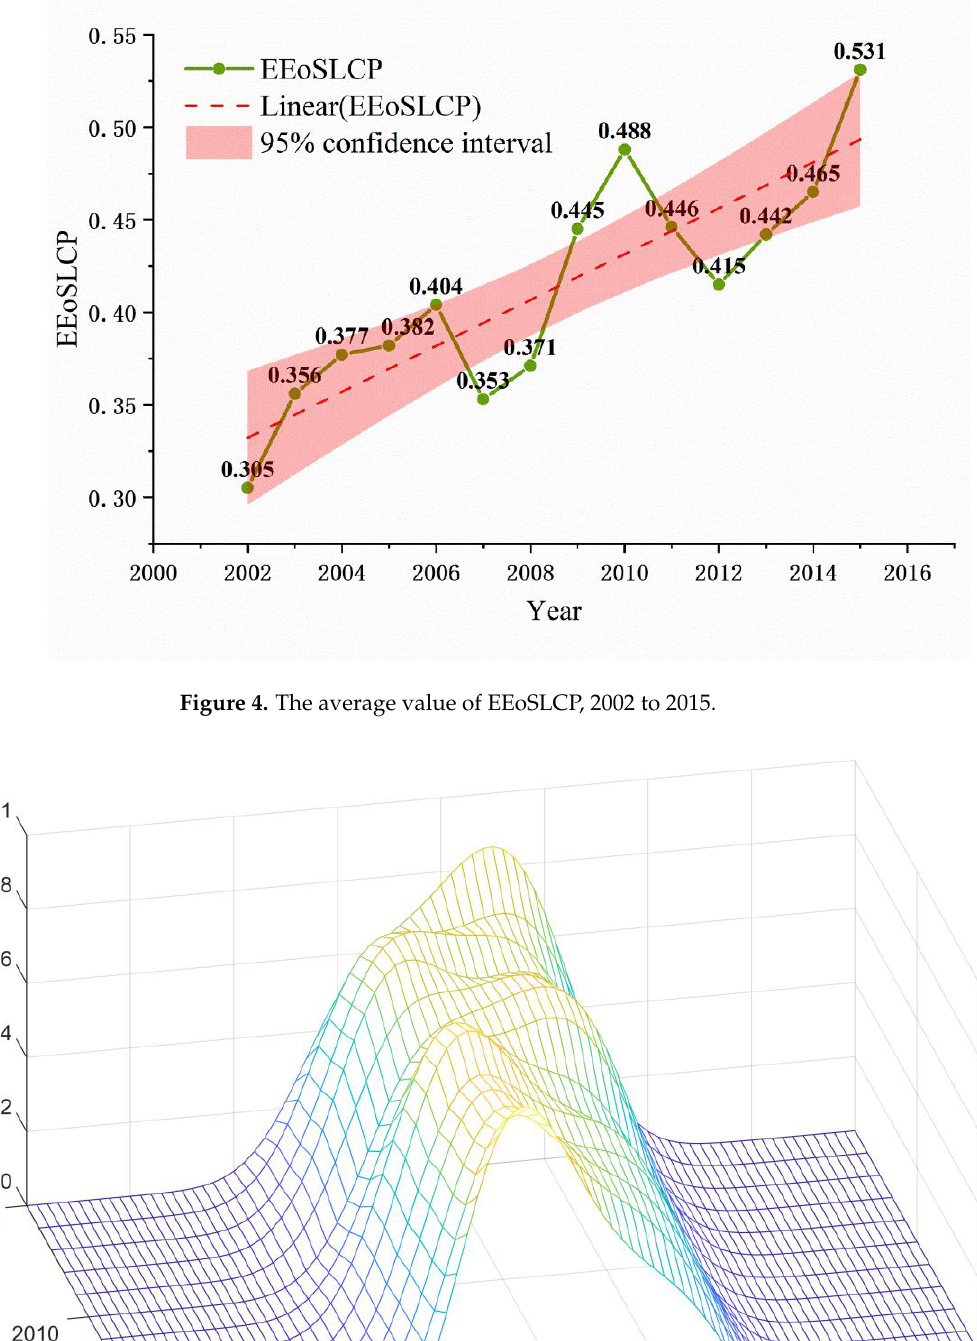
11 of 28 Figure 3. Variation of ( a ) VFC, ( b ) VCS, ( c ) SR, ( d ) WC, and ( e ) Biod from 2002 to 2018; ( f ) VFC, ( g ) VCS, ( h ) SR, ( i )WC, and ( j ) Biod have changed significantly ( p < 0.05) from 2002 to 2018. 3.2. Temporal Changes and Evolution of EEoSLCP The EEoSLCP of the LP and its 314 counties from 2002 to 2015 was measured using the DEA-BCC model selected by MaxDEA software. Figure 4 shows the average score of EEoSLCP for LP from 2002 to 2015. Firstly, it was found that the average EEoSLCP score for the LP from 2002 to 2015 was low, with an overall average score of only 0.413. Sec- ondly, the EEoSLCP presented an overall growth trend from 0.305 in 2002 to 0.531 in 2015, indicating that EEoSLCP has been effectively improved over time. Finally, based on the